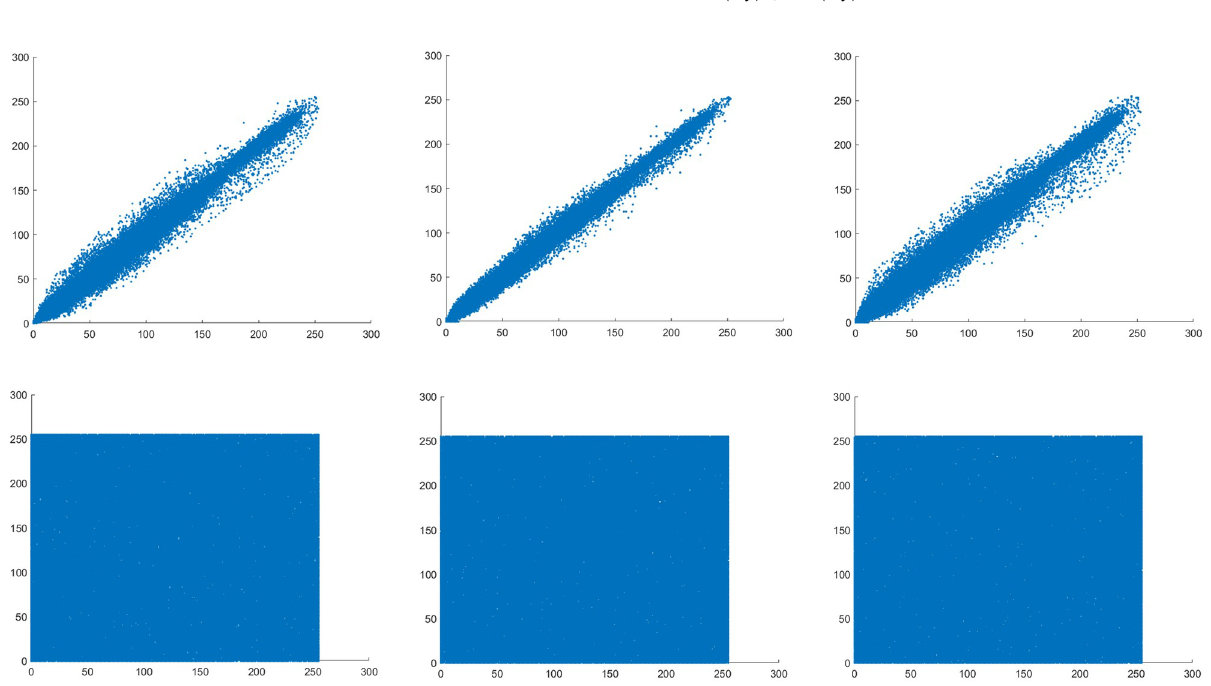
Fig 11. Horizontal, vertical, diagonal correlation point diagrams of original image and encrypted image. (a) original image horizontal, (b) original image vertical, (c) original image diagonal, (d) encrypted image horizontal, (e) encrypted image vertical, (f) encrypted image diagonal.